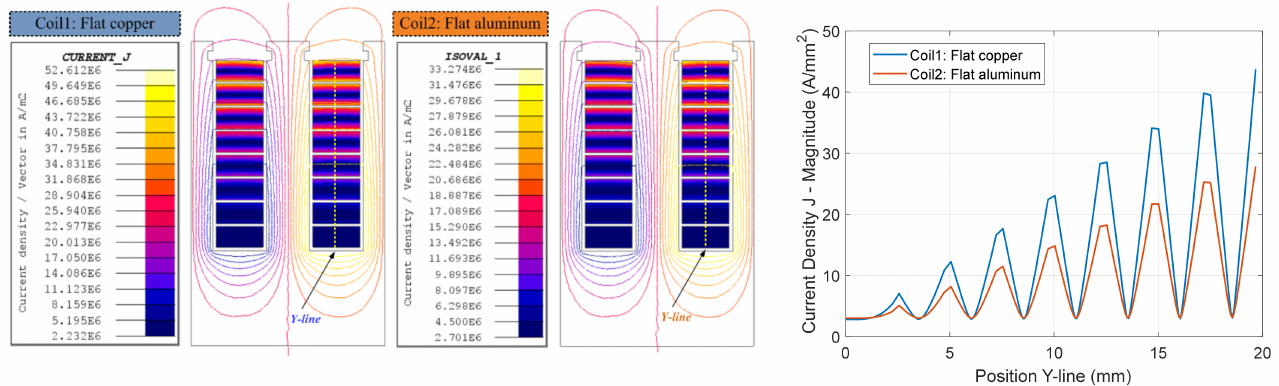
Figure 4. Comparison between current density distributions using copper and aluminum materials at 2 kHz.